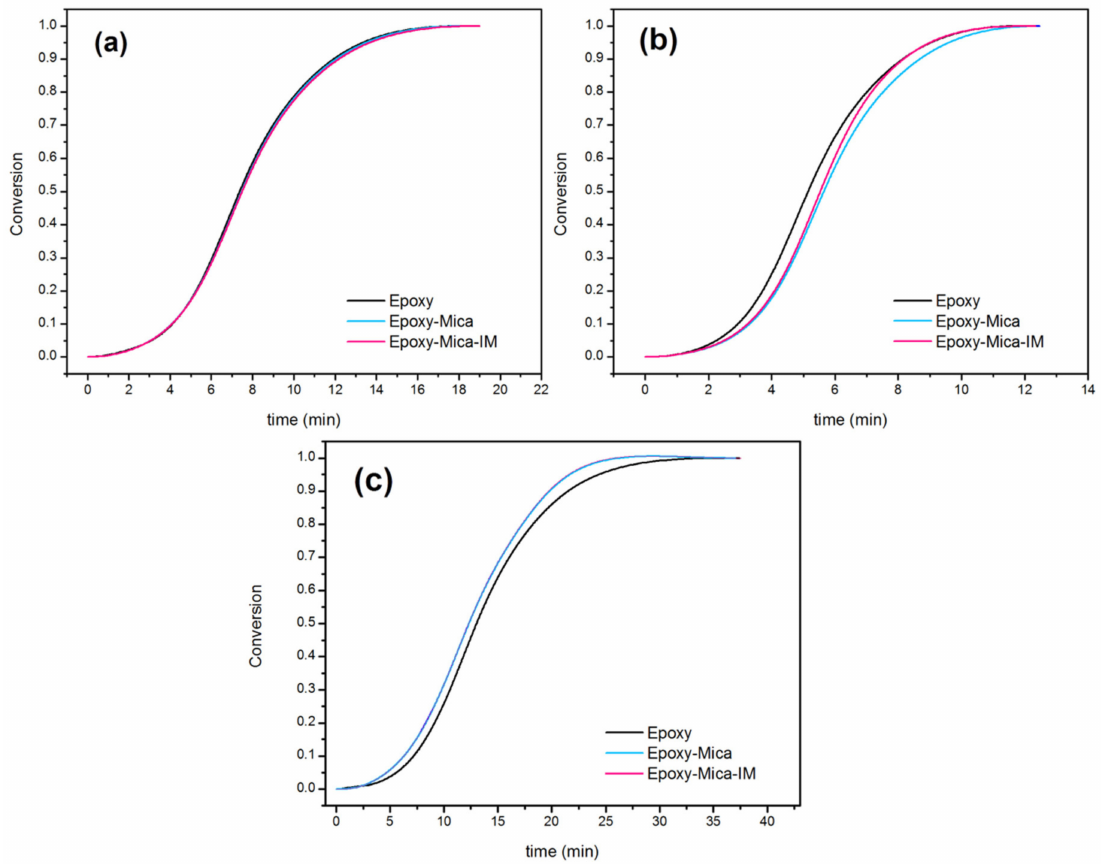
Figure 8. Conversion of cure reaction against time at β of 5 ◦ C min − 1 ( a ), 10 ◦ C min − 1 ( b ) and 15 ◦ C min − 1 ( c ) for blank epoxy and epoxy nanocomposites filled with 0.1 wt % Mica and